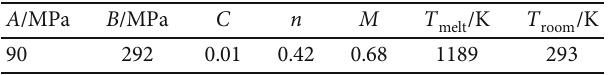
Table 5: Parameters of the Johnson-Cook model for the bullet jacket material.